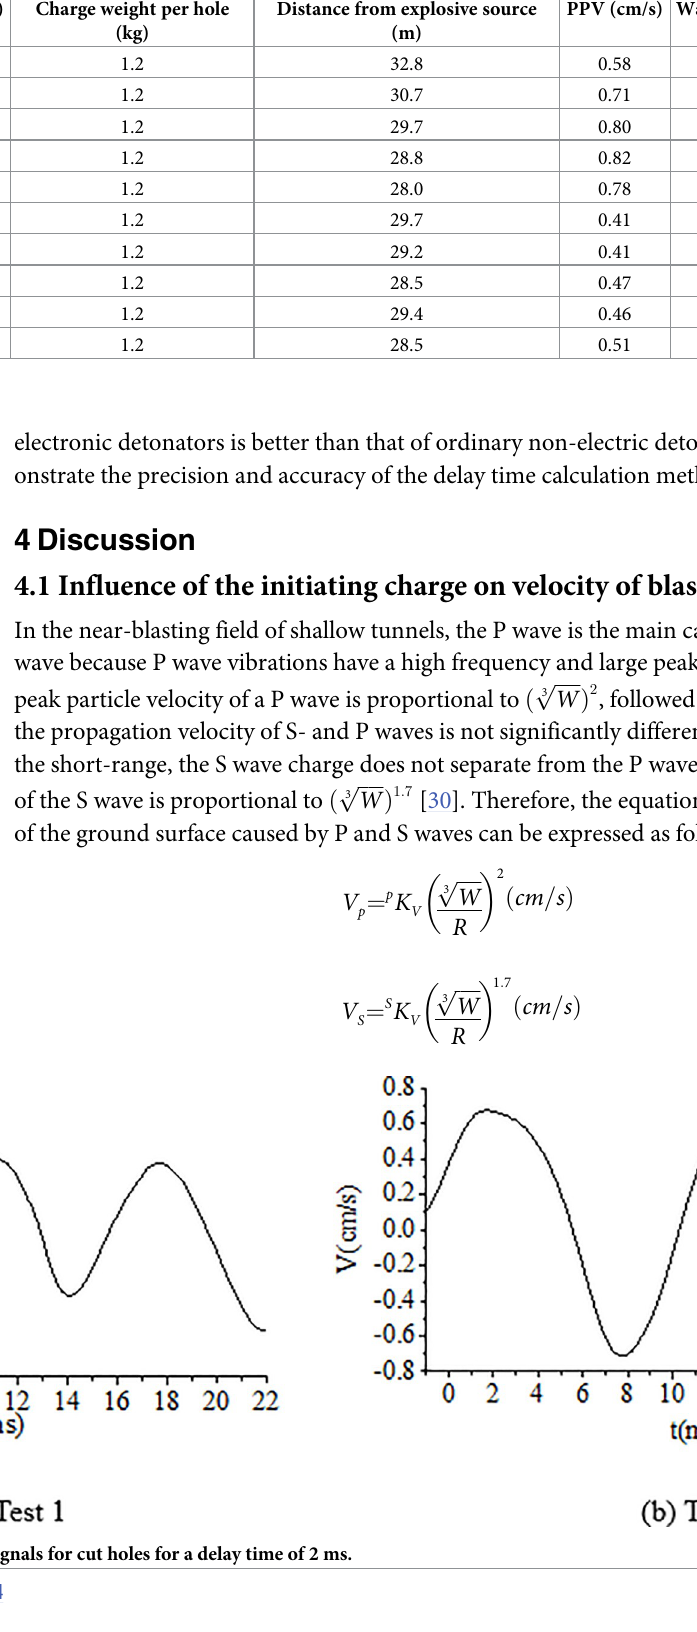
Table 5. Test results of different delay times for cut holes. Test number